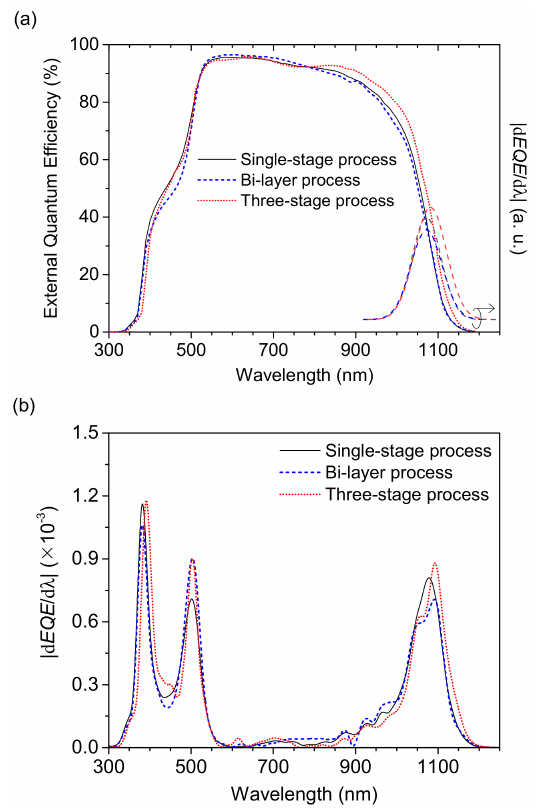
Figure 7. ( a ) External quantum efficiencies of CIGS solar cells prepared by the single-stage, bi-layer, and three-stage processes, and ( b ) the absolute values of d( EQE )/d λ as a function of